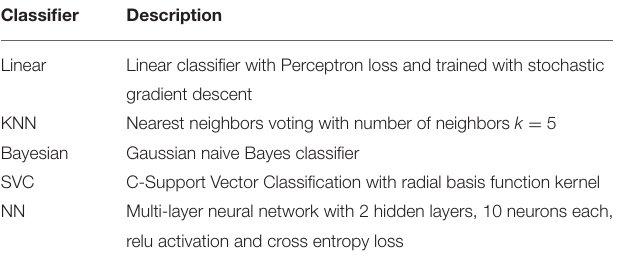
TABLE 1 | Evaluated classifiers for a grid exploration and to test the proposed optimization method on real-world data: Details can be found in Pedregosa et al. (2011).